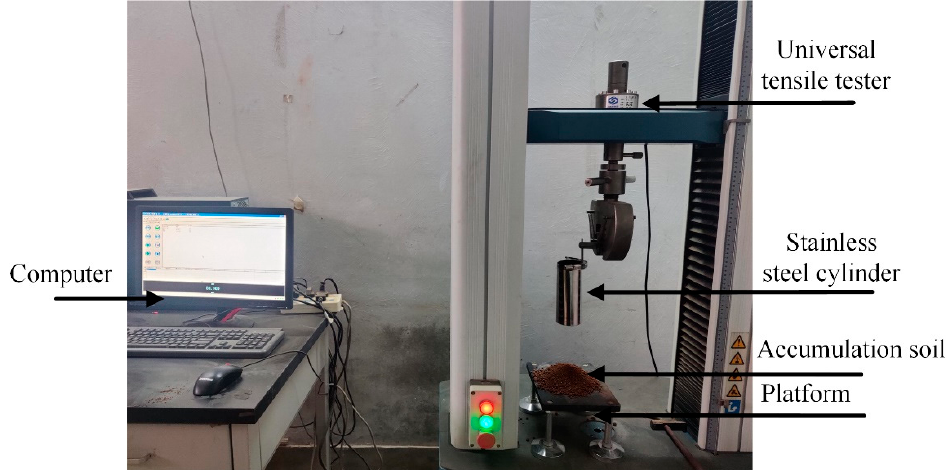
Figure 5. Soil repose angle test device.